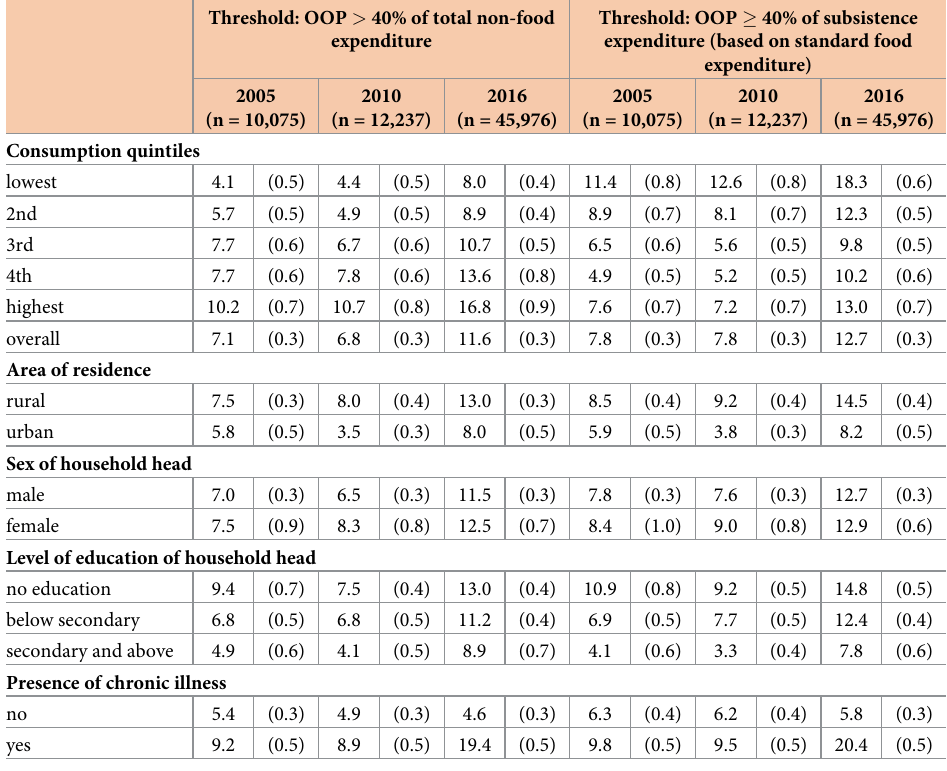
Table 5. The levels and distributions of the incidence of catastrophic health expenditure (%) by year; capacity-to- pay methods (actual food expenditure, and normative food expenditure methods). Threshold: OOP > 40% of total non-food Threshold: OOP � 40% of subsistence expenditure expenditure (based on standard